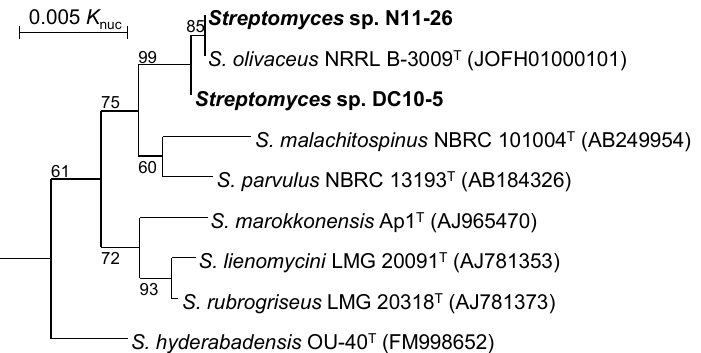
Figure 2. Phylogenetic tree based on 16S rRNA gene sequences. Type strains of species showing sequence similarities of >99.0% to strains N11-26 and DC10-5 are included in this tree. Numbers on the branches are the confidence limits estimated by bootstrap analysis with 1000 replicates, and values above 50% are indicated at branching points. Streptomyces albus NBRC 13014 T (AB490769) was used as an outgroup (not shown) to show the root.